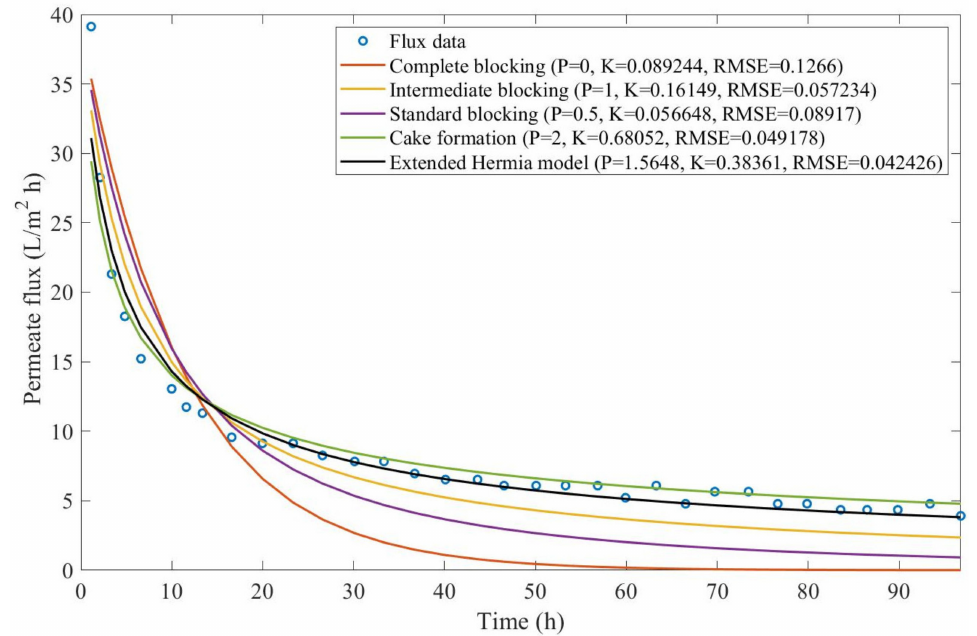
Figure A15. Model fitting for oily effluent ultrafiltration with CFR of 14 L/min and 21 kPa considering the four original pore-blocking mechanisms and the extended Hermia model